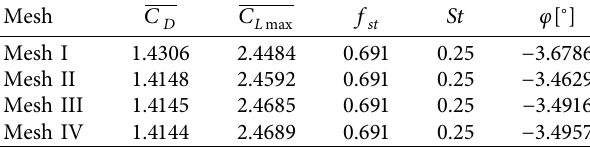
Table 3: Force coefficient and phase between lift and displacement. Mesh C D C L